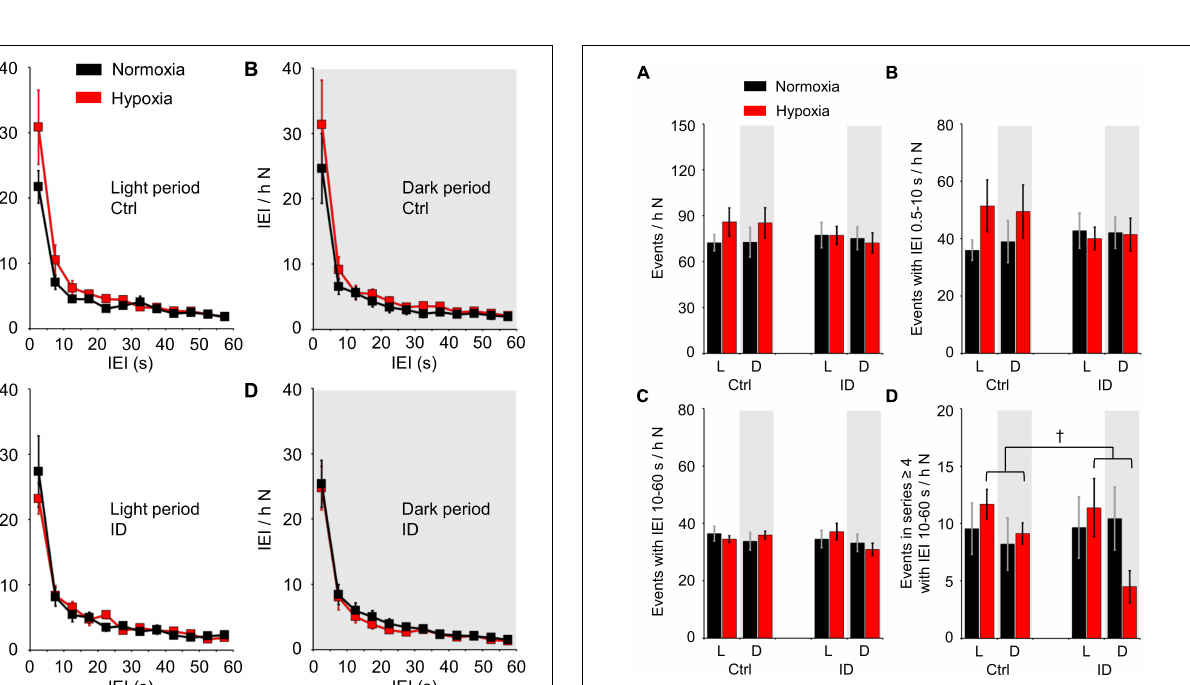
FIGURE 3 | Values of minute ventilation per unit body weight (A) , ventilatory period (T TOT , B ), and tidal volume per unit body weight (VT, C ) during non-rapid-eye-movement sleep (N) and rapid-eye-movement sleep (R) in mice fed control diet (Ctrl) or iron-deficient diet (ID) during normoxia (black) and hypoxia (red). Data are means ± SEM with n = 11 per group. ∗ and † , P < 0.05, main effects of hypoxia and sleep state, respectively (ANOVA).